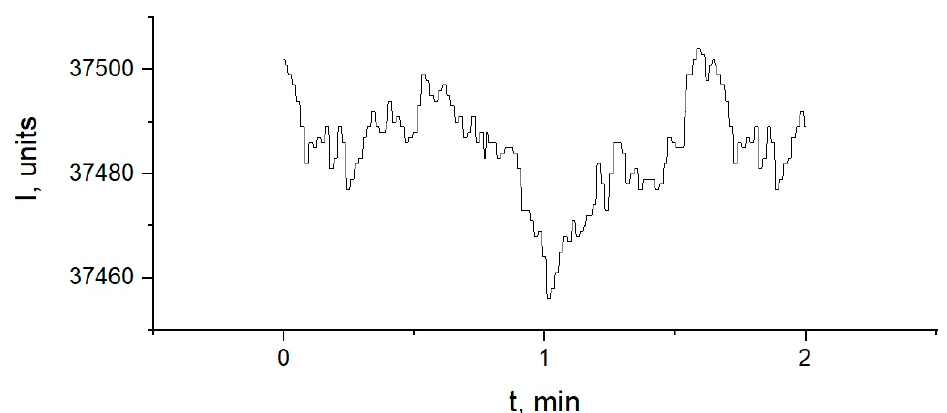
Figure 2. Example of time dependence of intensity of the light transmitted by 20% albumin solution without dye: I–the intensity of the light transmitted, t–recording time of the signal.